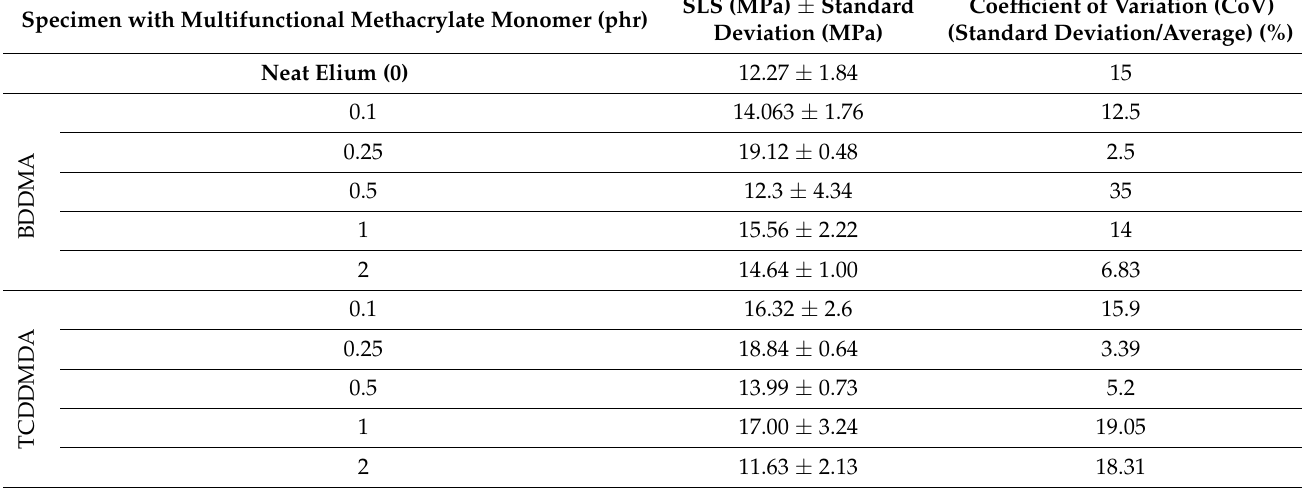
Table 4. The range of lap shear strengths for the